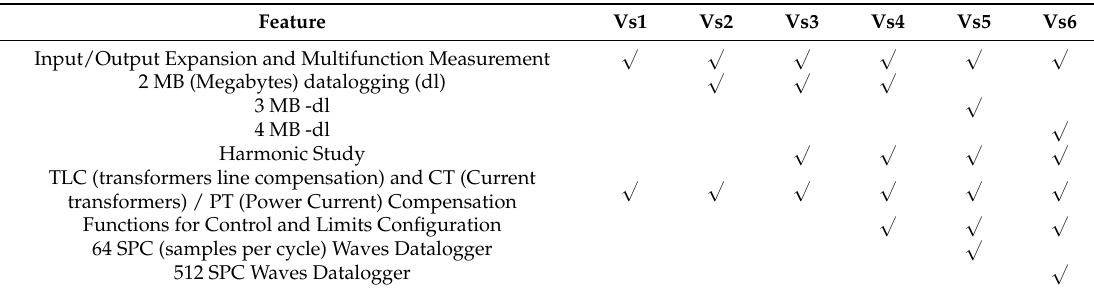
Table 2. Features of the V-Switches